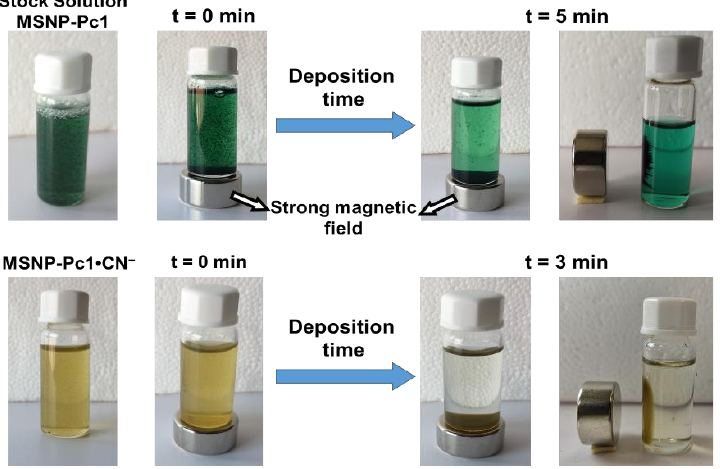
Figure 7. Colorimetric response of MSNP-Pc1 for reversibility and reusability tests with CN − ion ( left ). UV–Vis spectral changes of the complex MSNP-Pc1 • CN − treated with a TFA water solution (5.0 × 10 − 3 mol.dm − 3 ) ( right ).